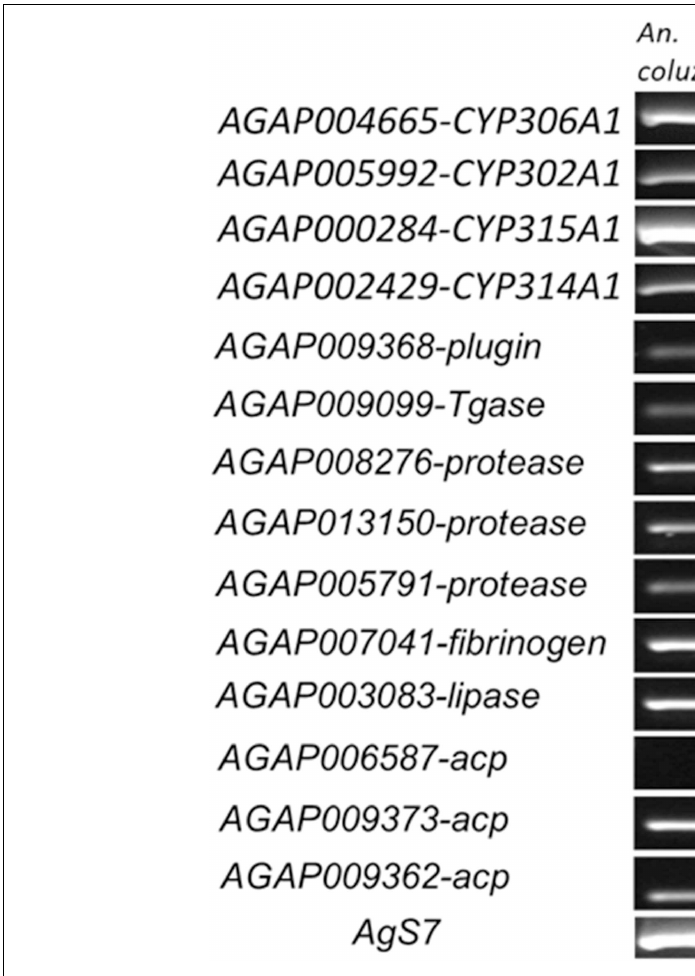
FIGURE 5 | The RT-PCR analysis of gene expression in the male reproductive tract. M × C,